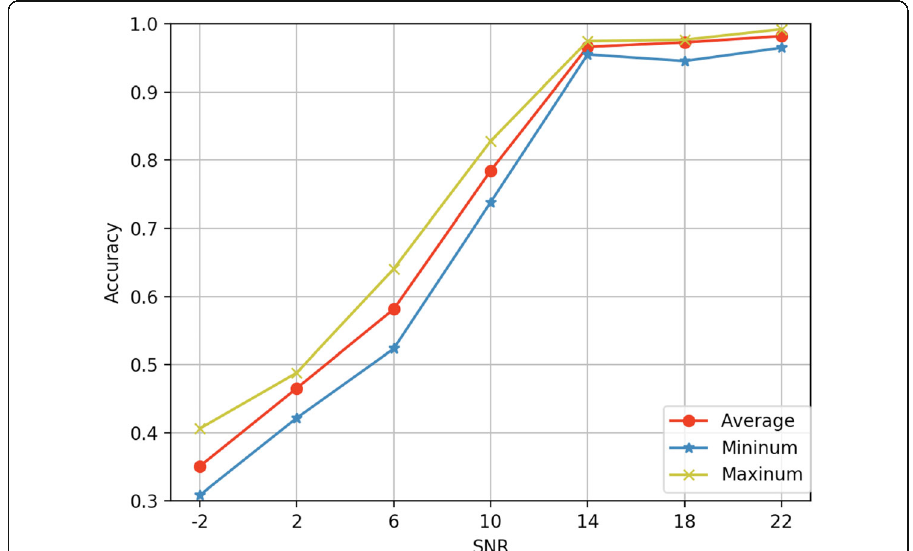
Fig. 19 Accuracy under different